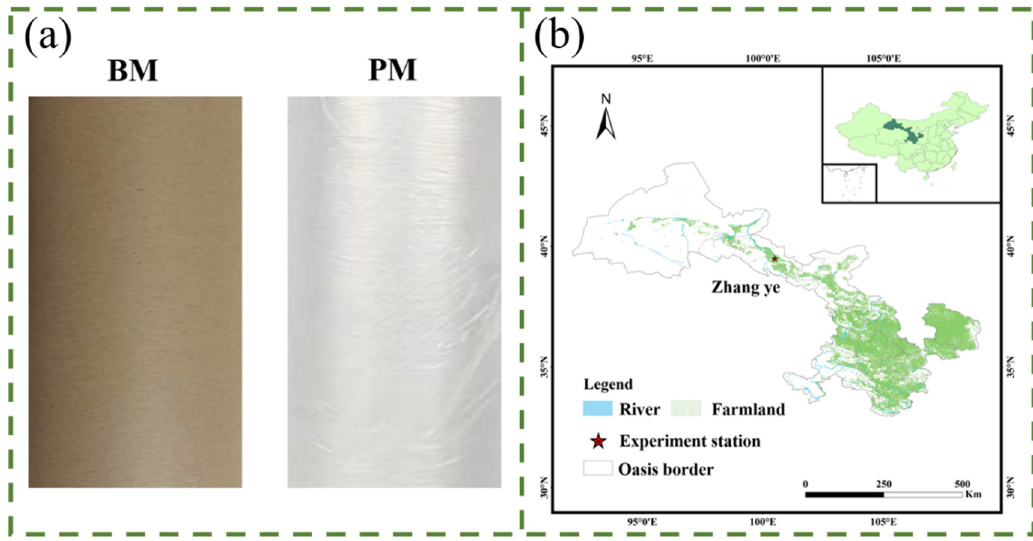
Figure 1. ( a ) Soil covering materials used in this study. BM, biodegradable paper mulch film; PM, white plastic film. ( b ) Location of the study area.